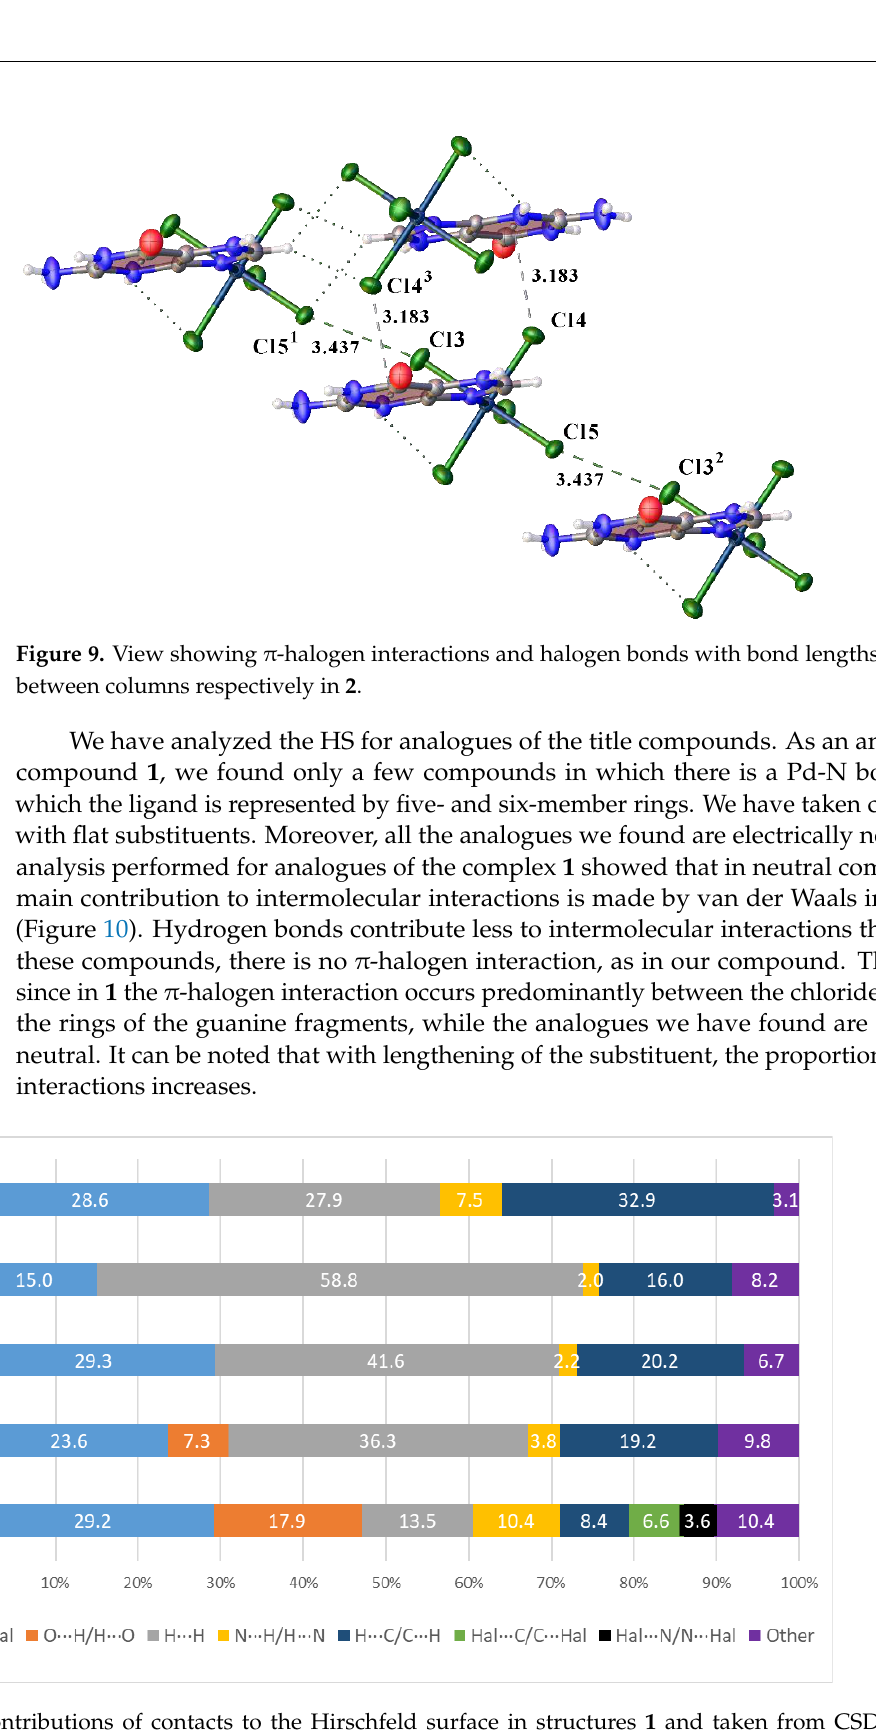
Figure 8. View showing π - stacking and π -halogen interactions with bond lengths between layers in the structure 1 .